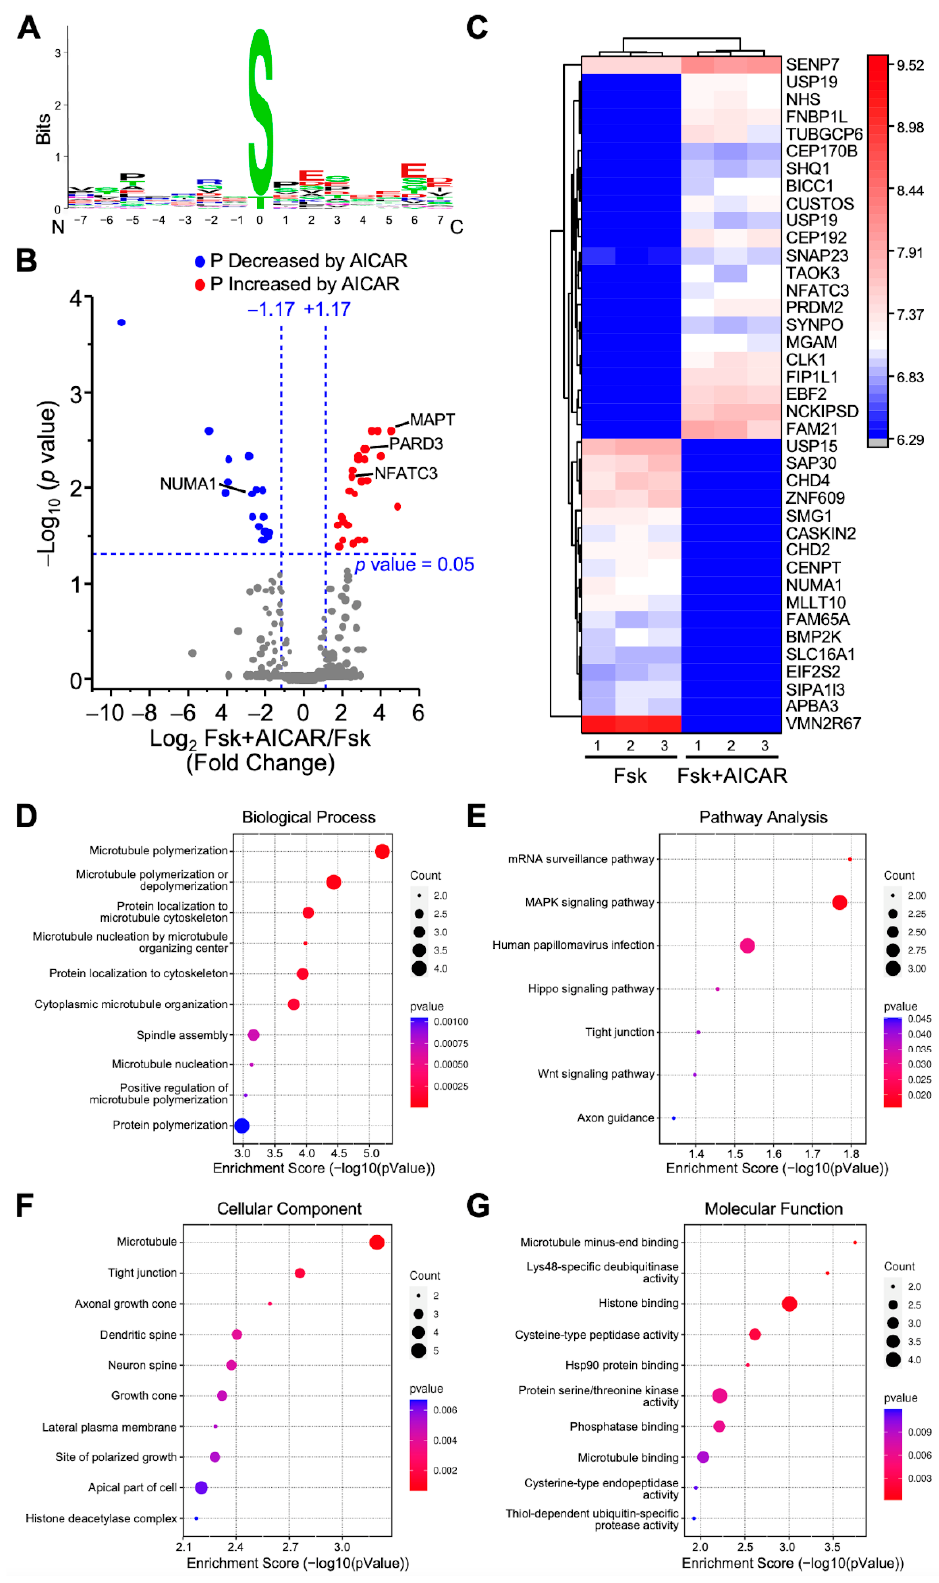
Figure 3. Analysis of differentially phosphorylated proteins in MA-10 Leydig cells treated with Forskolin or Forskolin+AICAR. LC-MS/MS was performed on enriched phosphopeptides extracted and digested from MA-10 Leydig cells treated with Forskolin (Fsk, 10 µm) or Fsk+AICAR (10 µM and 1